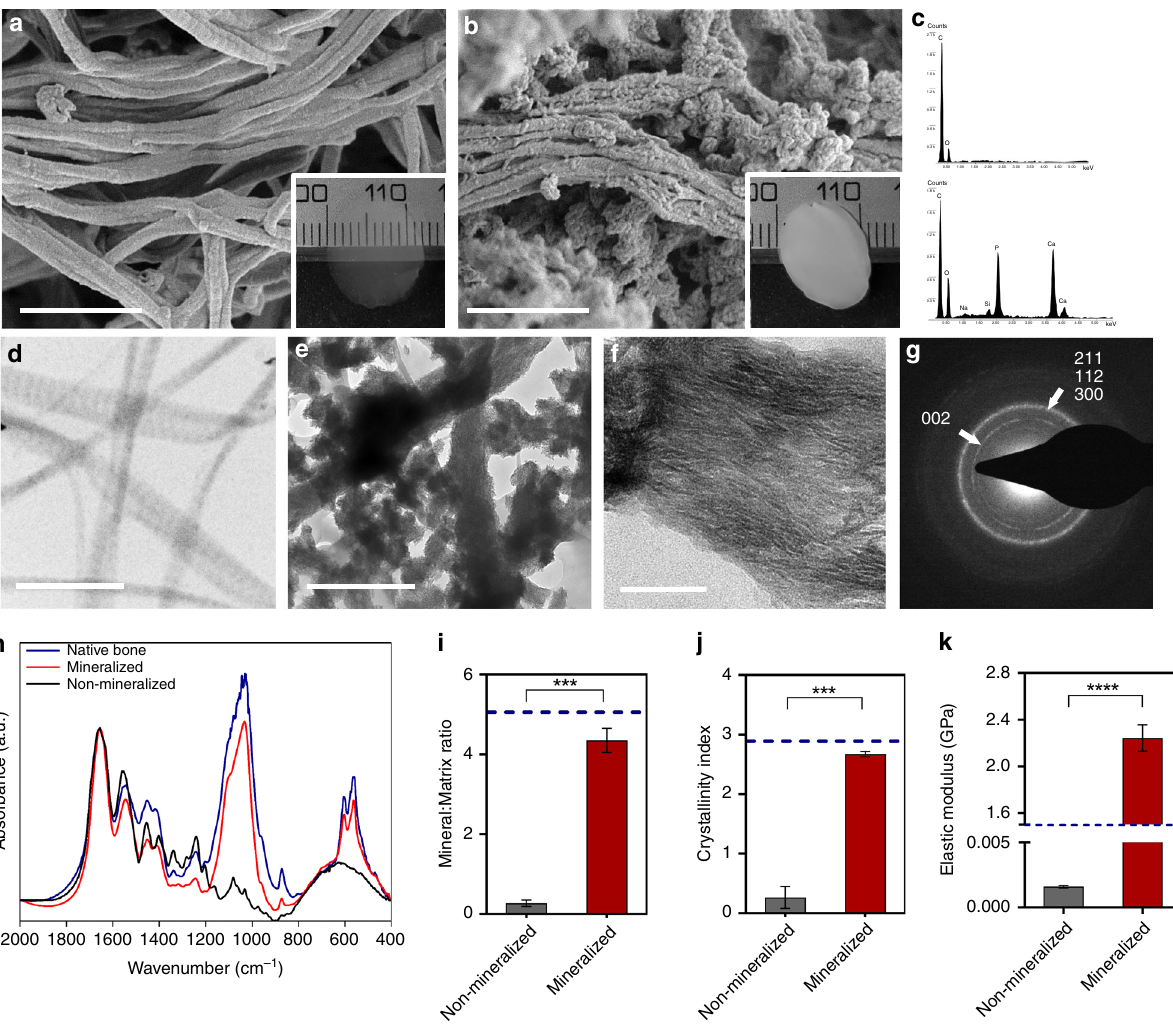
Fig. 1 Nanostructure, composition, and characterization of mineralized collagen. SEM images of ( a ) non-mineralized and ( b ) mineralized collagen showing the formation of fi bril bundles. Extra fi brillar mineral is apparent in b . ( N = 4). Scale bar: 400 nm. Insets: Collagen hydrogels prior to ( a ) and immediately after ( b ) a 3-day mineralization period. The mineral formation resulted in a white opaque appearance. c EDX spectra of mineralized samples con fi rmed the presence of Ca and P in mineralized specimens (bottom), and lack thereof in non-mineralized controls (top). ( N = 4). TEM images of ( d ) non-mineralized collagen showed the typical D-banding pattern of collagen, while the banding becomes obscured in the ( e ) mineralized collagen, which appears to have both intra and extra fi brillar mineral crystallites (Supplementary Movie 1). Scale bar: 500 nm. ( N = 4). f The zoomed view of a single mineralized fi bril suggests the preferential orientation of intra fi brillar mineral apatite crystallites (dark streaks) in the (001) position, parallel to the c-axis of the fi bril. Scale bar: 50 nm. g Selective area electron diffraction (SAED) of a mineralized collagen shows the typical broad arcs for the (002) plane and overlapping arcs for the (112), (211), and (300) planes that are consistent with the known hexagonal crystalline structure of hydroxyapatite. h FTIR spectra and respective ( i ) mineral:matrix ratio (**** p < 0.0001, Student ’ s t -test) and ( j ) crystallinity index (*** p < 0.001, Student ’ s t -test) of mineralized and non-mineralized collagen constructs, dotted lines are reference values of native bone. Data are represented as mean ± SD ( N = 6). k AFM nanoindentation modulus of non- mineralized and mineralized hydrated collagen fi brils. Mineralization resulted in over a 1000-fold increase in stiffness for individual fi brils (**** p > 0.0001, Student ’ s t -test) ( N = 3). Dotted line is a reference value of native mineralized collagen 51 . Source data are provided as a Source Data fi